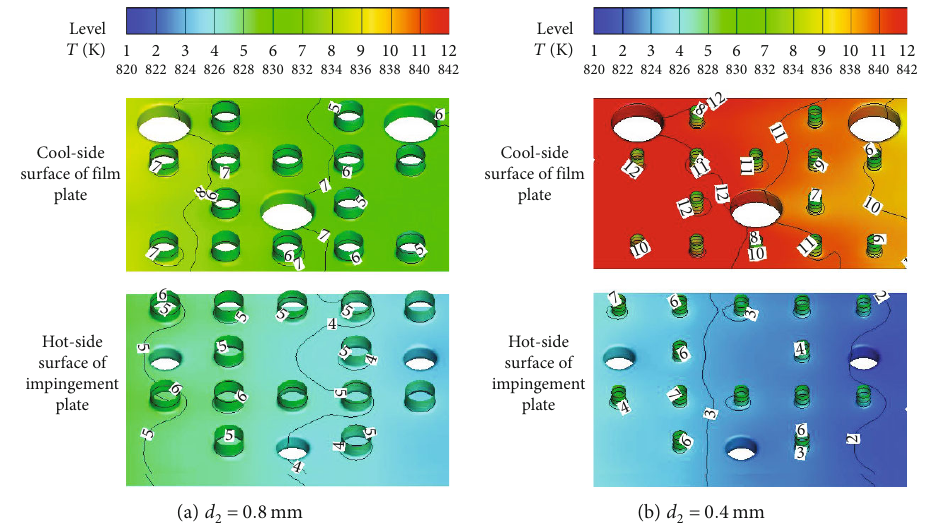
Figure 19: E ff ect of pin fi n diameter on temperature distribution.